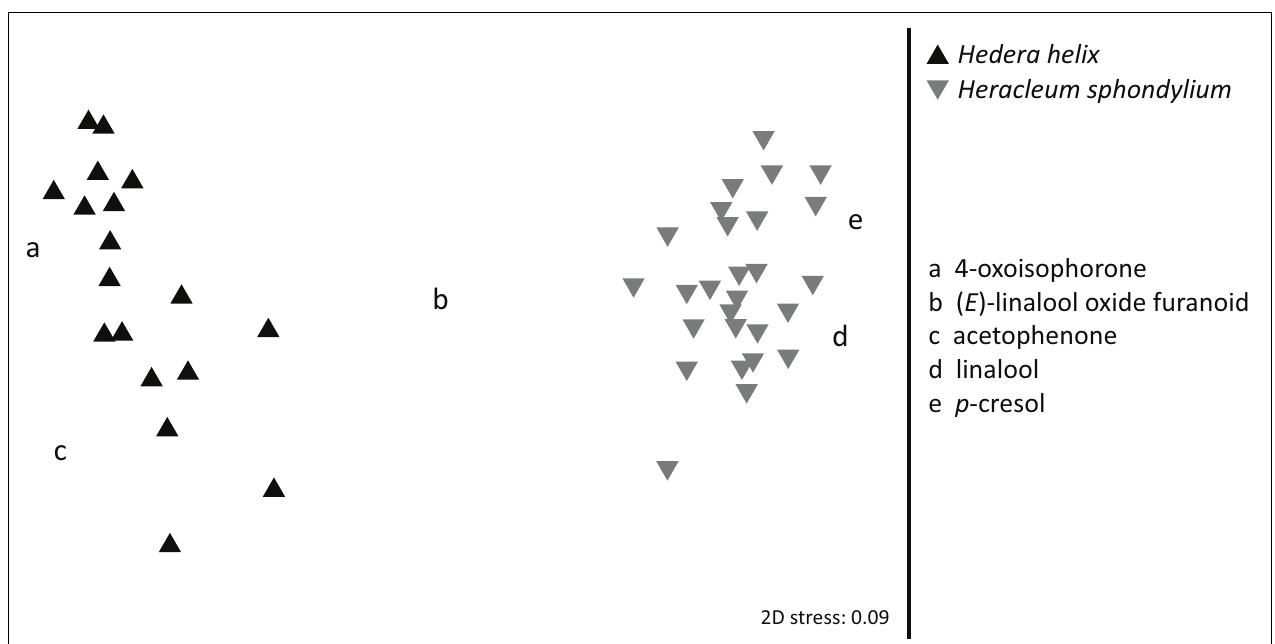
FIGURE 3 | Semi-quantitative differences between EAD-active compounds emitted by flowers of Hedera helix and Heracleum sphondylium . Letters describe the main floral compounds responsible for the differences between plants.